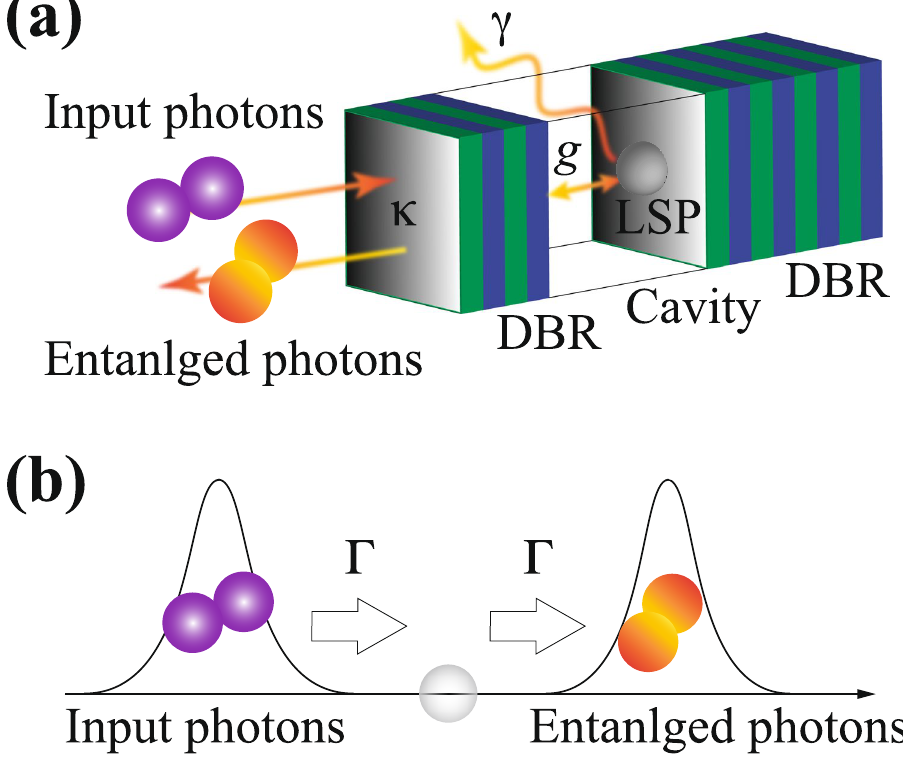
Figure 2. ( a ) Schematic of the conversion of input photons to an entangled photon pair via a cavity-plasmon system in which a single nanometal is confined in a microcavity. ( b ) One-dimensional input-output model of the cavity-plasmon system simplified under the condition of κ γ > > g